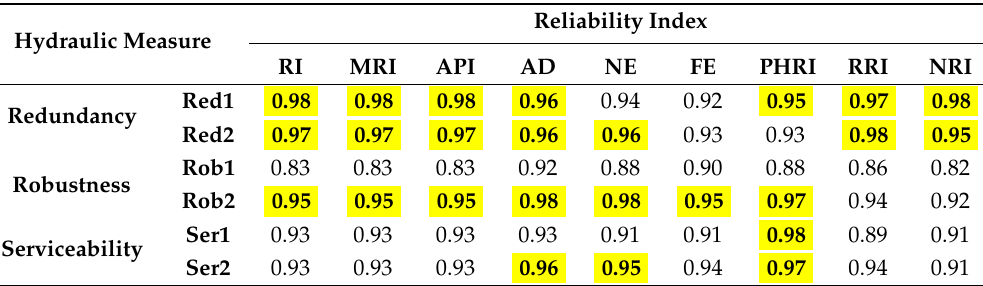
Figure 4. Scatter plots of Scenario 1 ( x -axis—Reliability index; y -axis—Hydraulic measures). The plots highlighted in yellow show high correlation coe ffi cient of 0.95 or higher. Table 4. Correlation coe ffi cients for Scenario